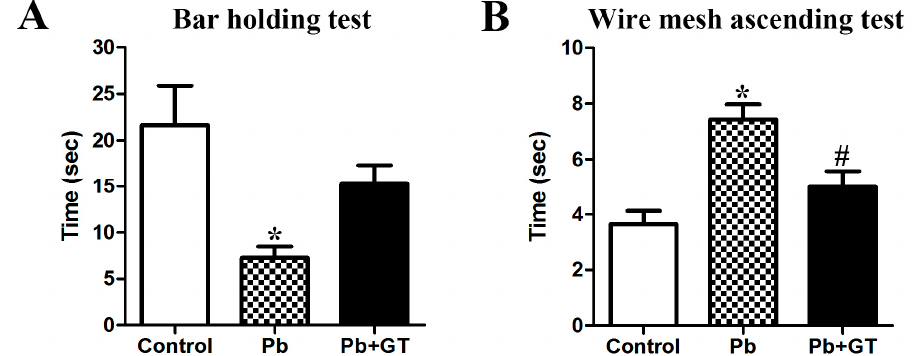
Figure 7. Effects of gintonin on Pb-induced locomotive impairments. Effect of Pb exposure and gintonin treatment on the bar holding test ( A ) and wire mesh ascending test ( B ) among offspring from control, Pb, and Pb plus gintonin (Pb+GT) groups. ( A ) The time during which the animal stayed on the bar ( p < 0.0001, one-way analysis of variance) in the bar holding test. ( B ) The time spent to reach the top of the wire mesh ( p = 0.0082, one-way analysis of variance) in the wire mesh ascending test (n = 12 per group). * p < 0.05, compared to control group; # p < 0.05, compared to Pb alone, Tukey’s post-hoc test. The bars indicate the means ± standard error of the mean.